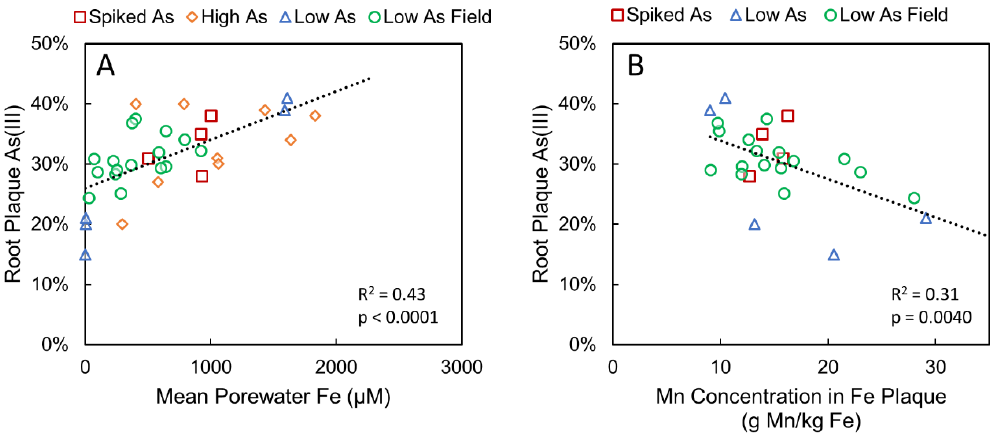
Figure 6. Relations between plaque iAs(III) and ( A ) porewater Fe and ( B ) Mn concentration in the Fe plaque for selected samples.